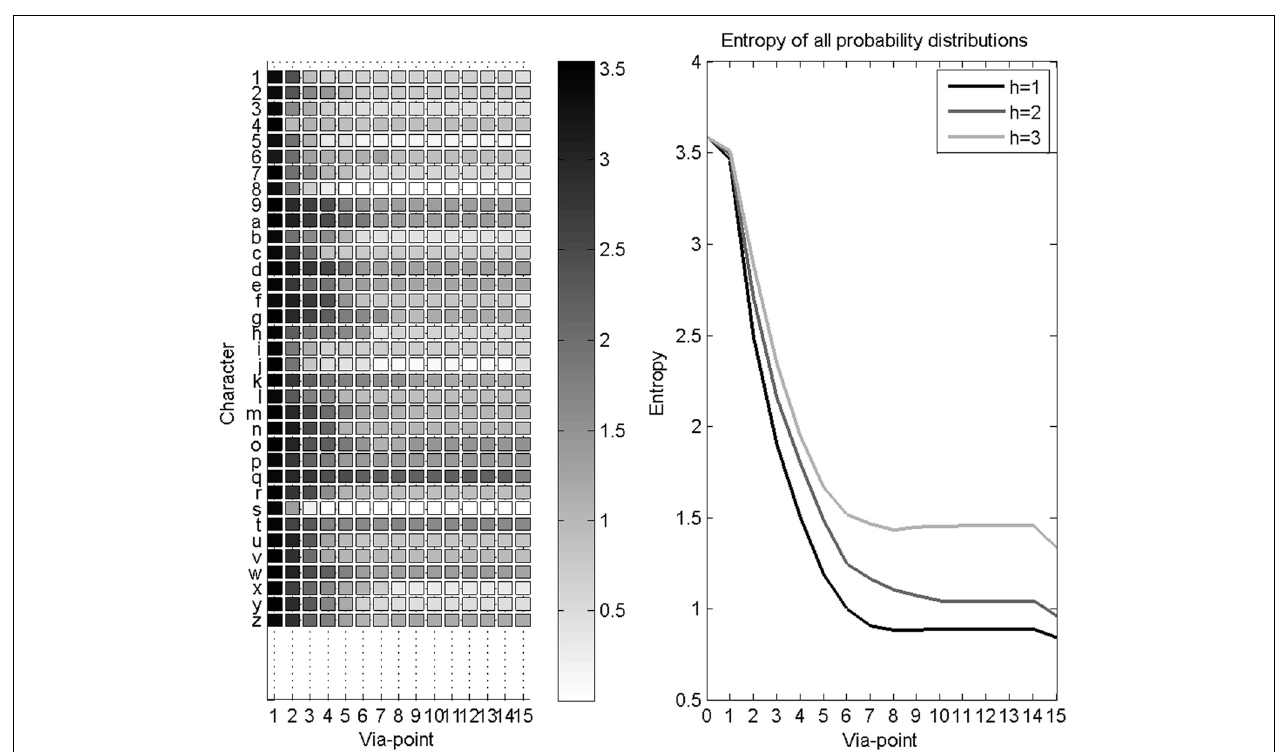
FIGURE 11 | Evolution of entropy during character recognition. Left panel: each row is the mean Shannon entropy of the probability distribution over letters, as via-points are accumulated, for a given letter. Right panel :